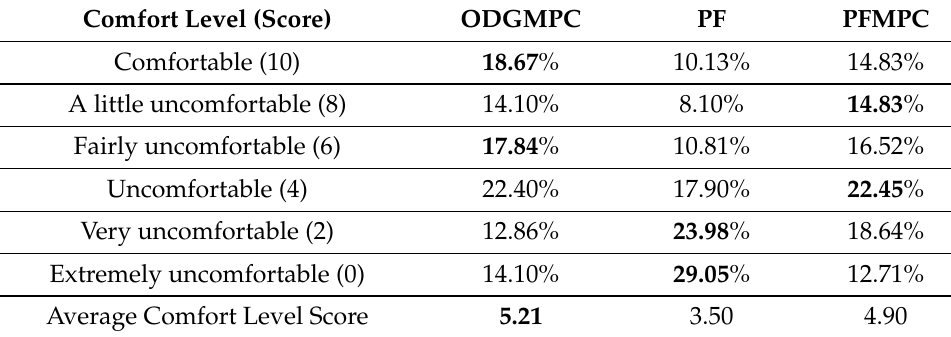
Figure 21. Results of the obstacle distance from Scenario 2 for a static obstacle. Table 6. Average result scores for 10 experiments in Scenario 2 for a static